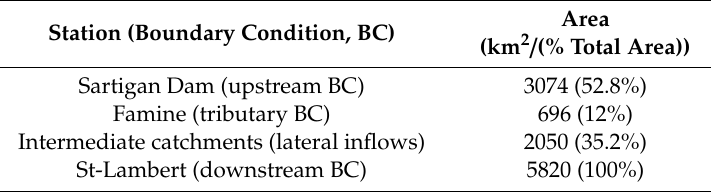
Table 2. Boundary conditions and ratio to the total catchment area.